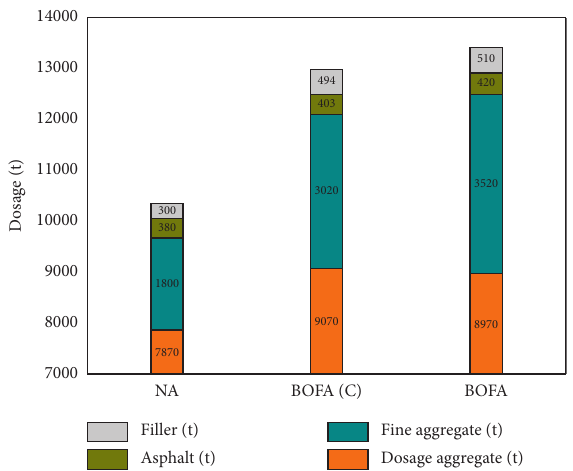
Figure 6: The demand for various raw materials for a 10km single lane of the lower surface